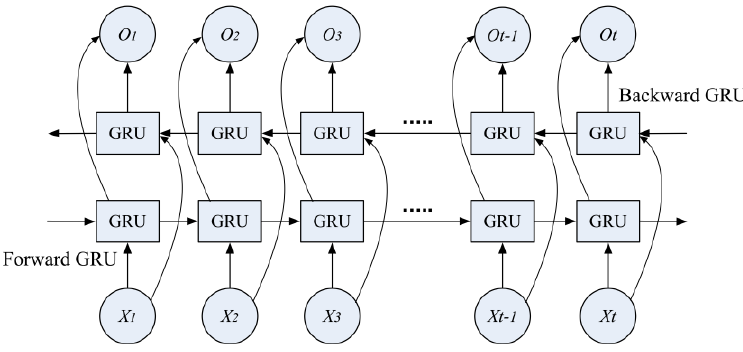
Figure 11. Schematic diagram of